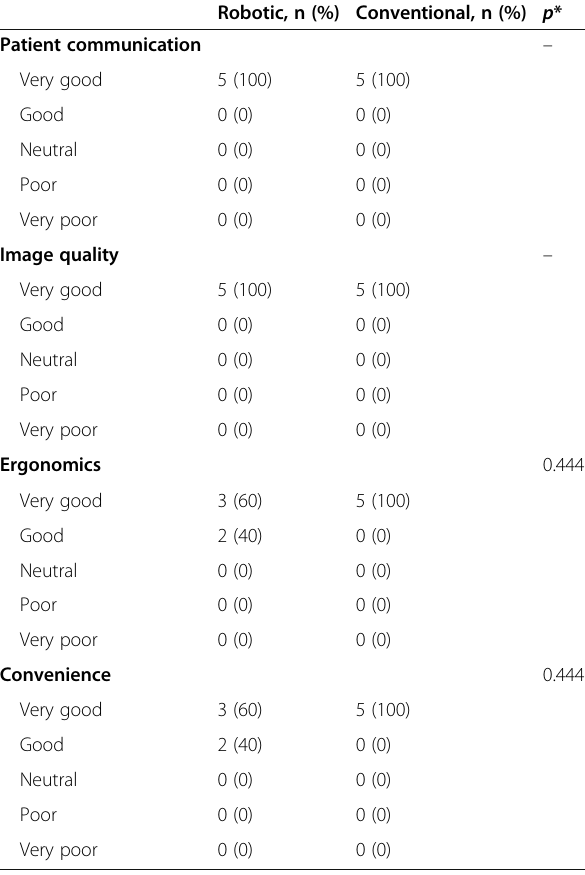
Table 1 Radiologist assessment of robotic and conventional